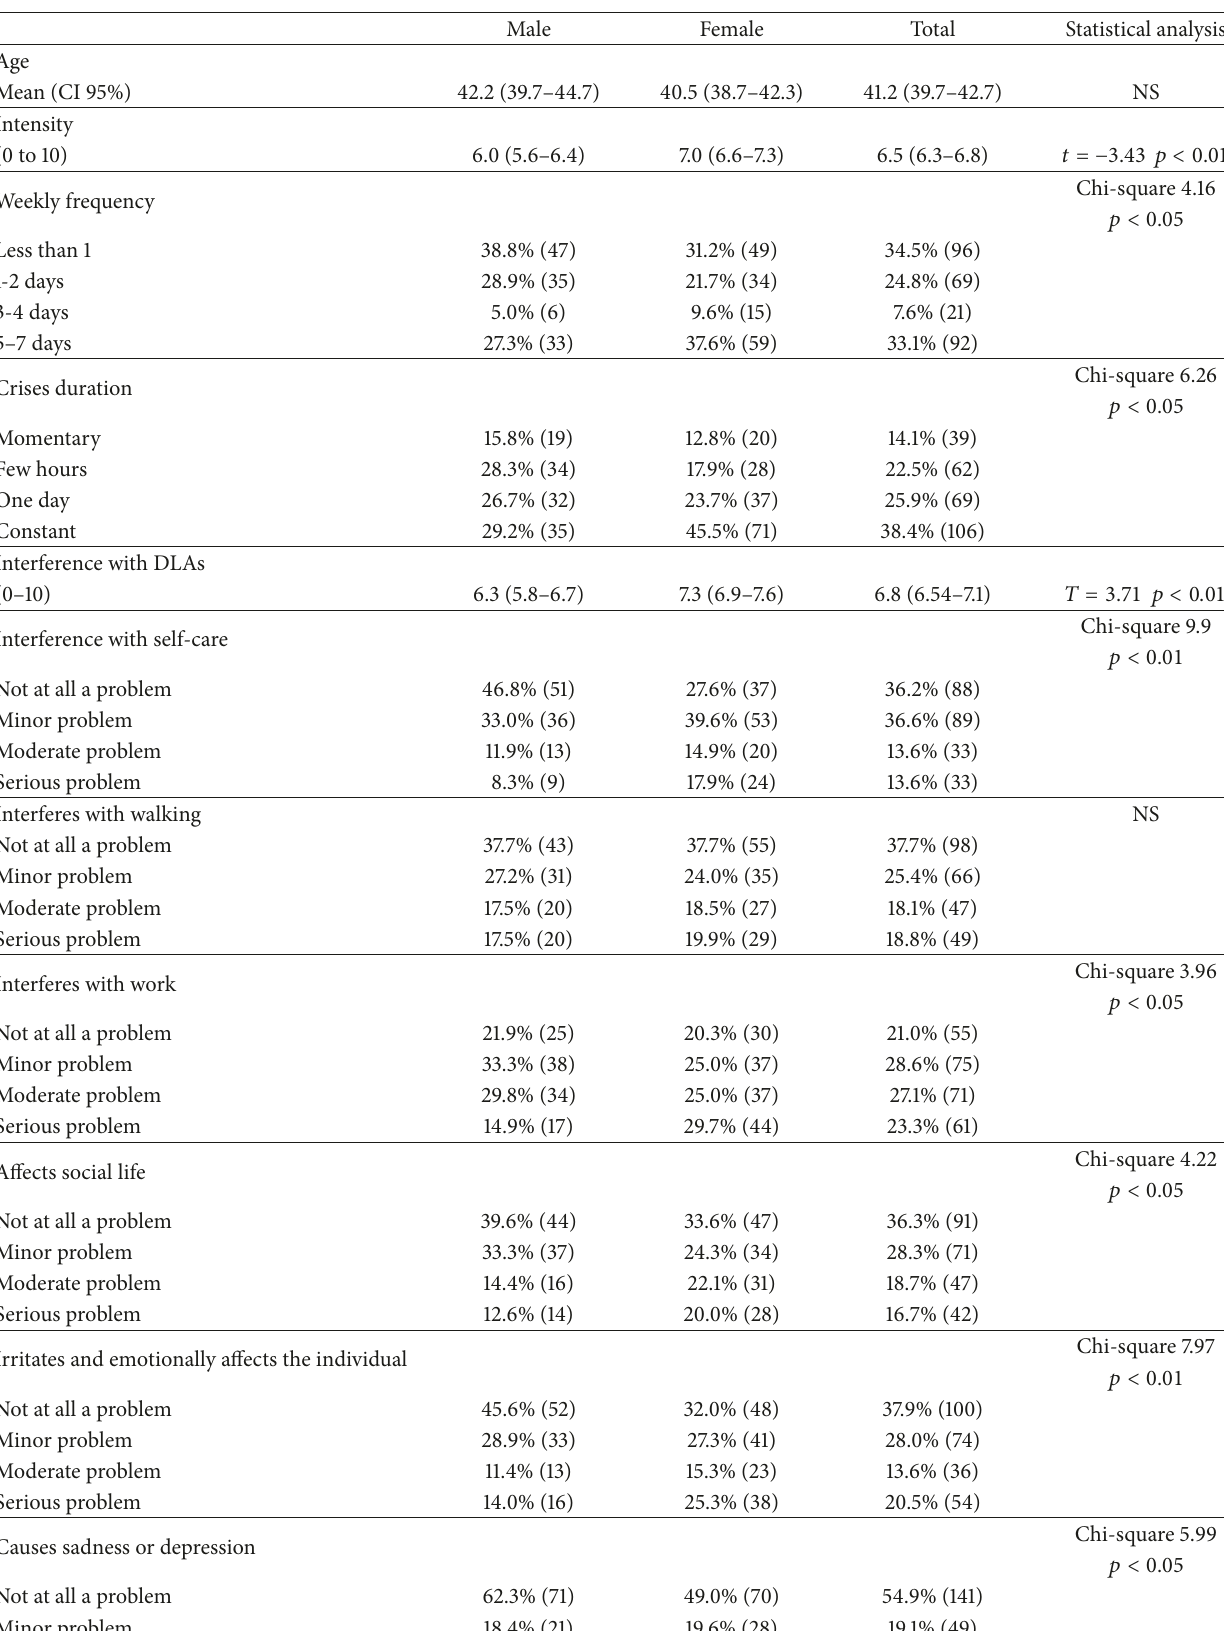
Table 3: Comparison of pain characteristics between genders in the Brazilian population